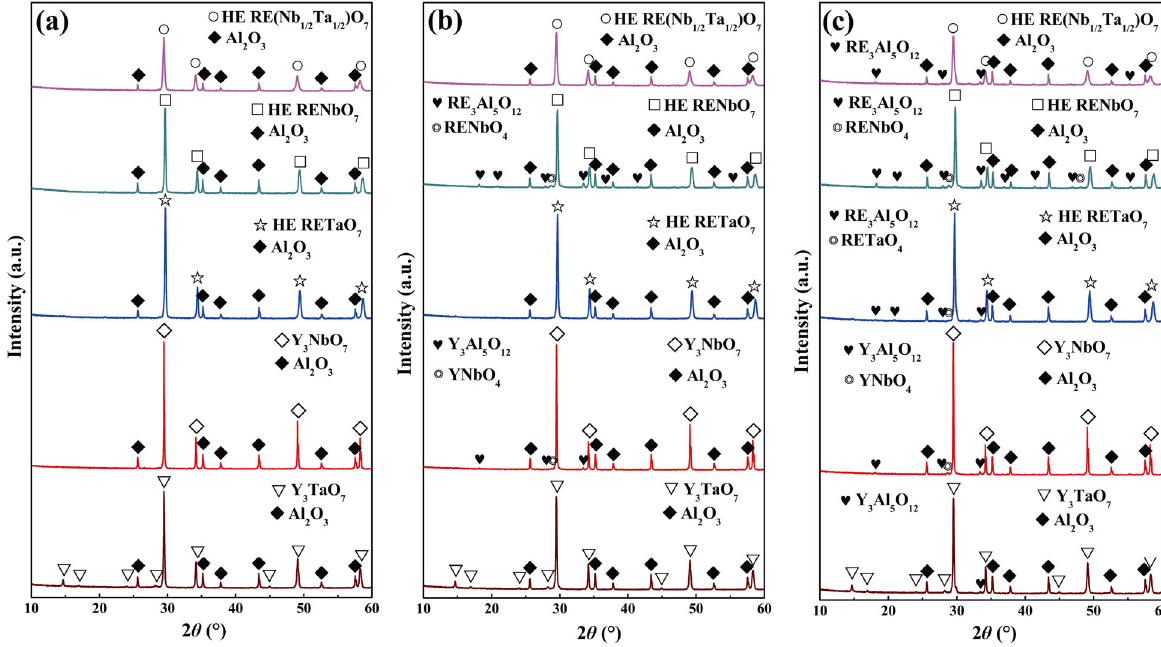
Fig. 5 XRD patterns of the mixed powders of Y 3 TaO 7 , Y 3 NbO 7 , HE RE 3 TaO 7 , HE RE 3 NbO 7 , HE RE 3 (Nb 1/2 Ta 1/2 )O 7 , and α-Al 2 O 3 after annealing at different temperatures for 2 h: (a) 1200 ℃ , (b) 1250 ℃ , and (c) 1300 ℃